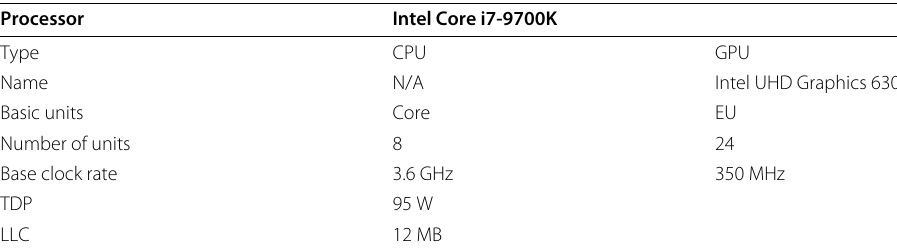
Table 1 Hardware